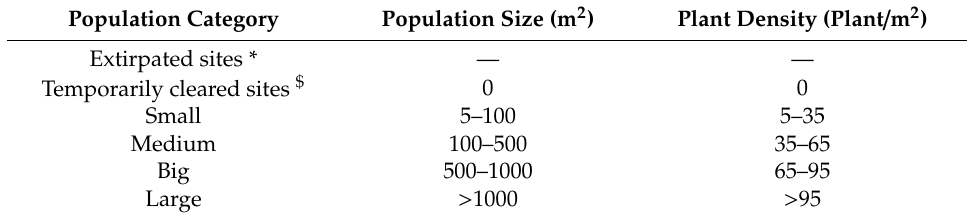
Table 2. Population size and plant density categories of Sagittaria platyphylla